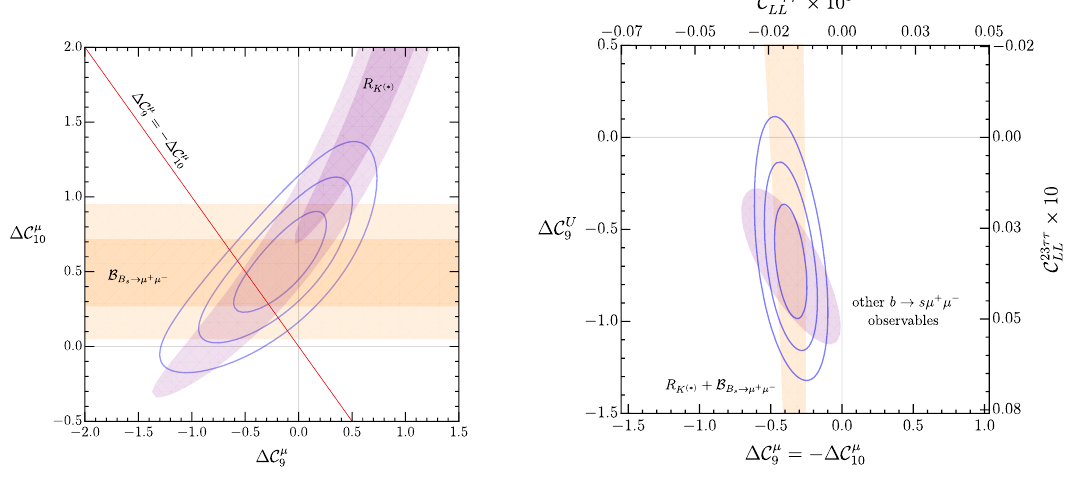
Figure 1 . EFT constraints from the b → s‘ + ‘ − anomalies. Left: results of the two-dimensional fit ∆ C µ vs. ∆ C µ using clean observables only ( 1 σ , 2 σ and 3 σ intervals). Also shown are the 1 σ 9 10 and 2 σ intervals from R and B ( B = 0 . Right: + µ − ) , the latter under the hypothesis ∆ C U s → µ K ( ∗ ) 10 results of the two-dimensional fit ∆ C µ = − ∆ C µ vs. ∆ C U using all b → s‘ + ‘ − observables. The 9 9 10 vertical band shows the result using clean observables only ( 1 σ interval), while the ellipse denote the contribution of all the other observables, estimated using Flavio ( 1 σ interval). The upper and right axes show the corresponding constraint on the high-scale EFT coefficients (see main